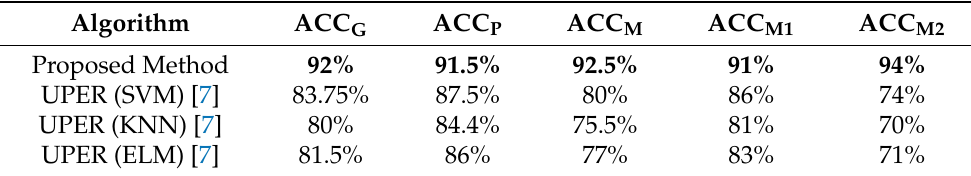
Table 2. Comparative ACC results between the proposed method and UPER. Algorithm ACC